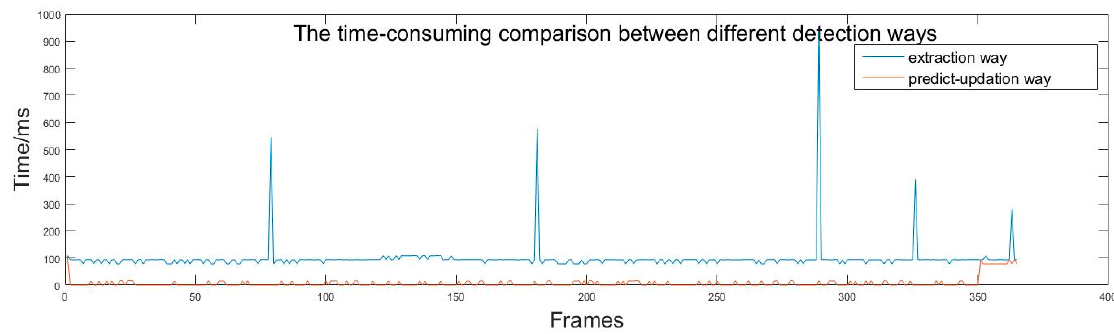
Figure 23. The road curb detection time-consuming experiment.